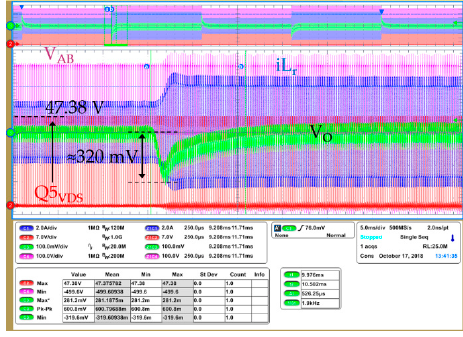
Figure 30. SRs overshoot during load jump.